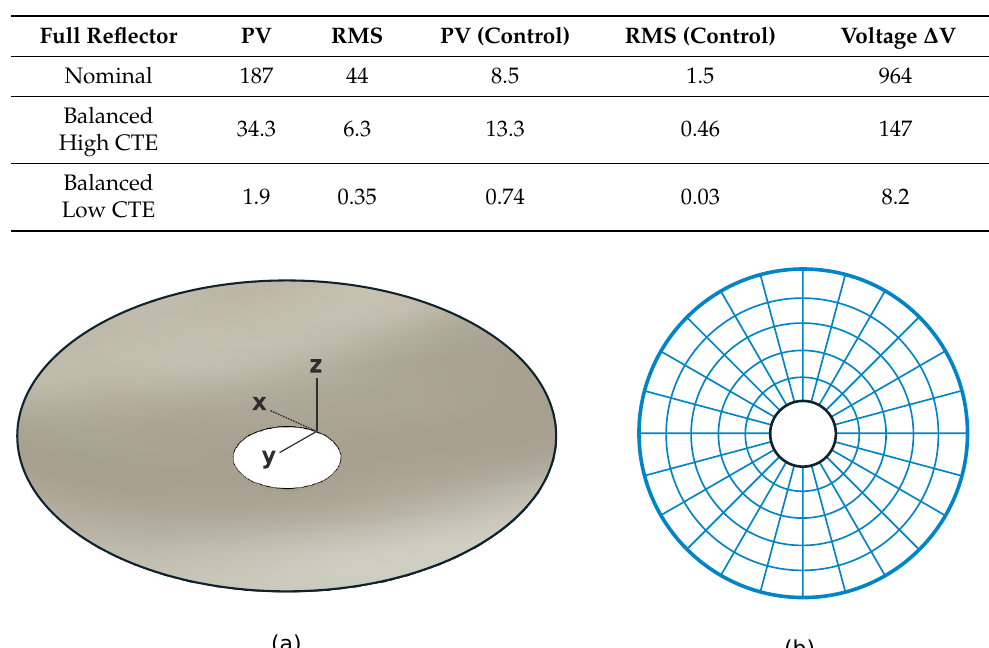
Table 3. Surface figure error due to a linear thermal gradient of ∓ 15 ◦ K, before and after control with an array of 120 electrodes. All amplitudes are in µ m and voltages in V.